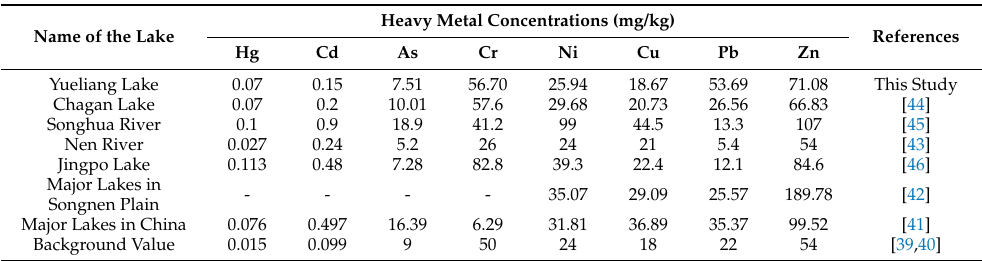
Figure 4 . Histogram of heavy metal contents in the surface sediment of Yueliang Lake. Figure 4. Histogram of heavy metal contents in the surface sediment of Yueliang Lake. Table 2. Heavy metal concentrations in the surface sediments from Yueliang Lake and other selected